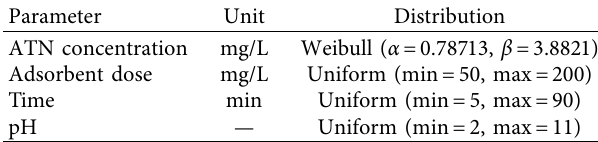
Table 2: Distribution of input parameters in the